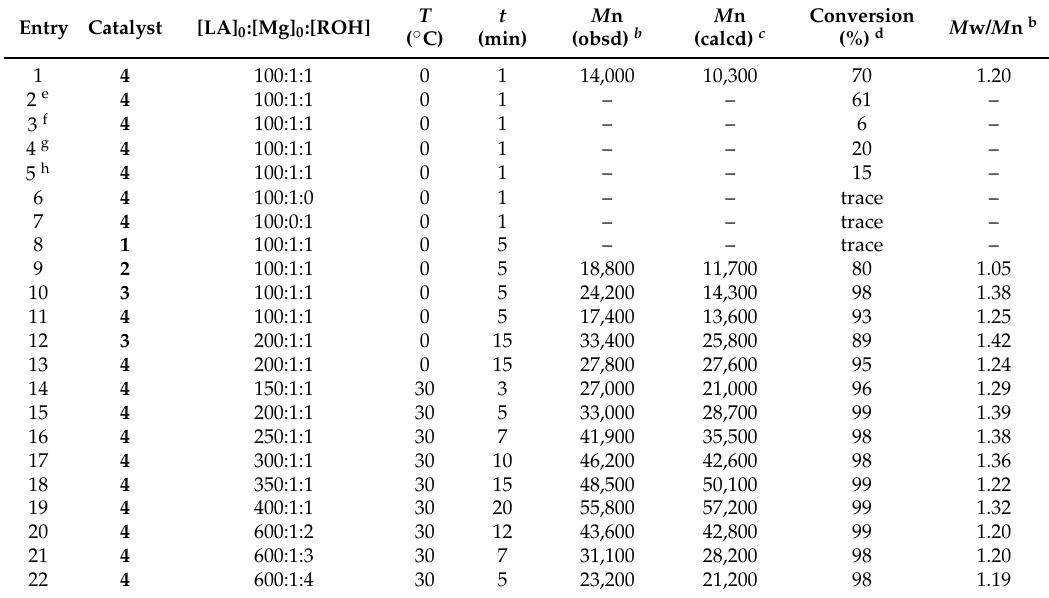
Table 3. Polymerization of L-LA using compounds 1 – 4 as catalysts in toluene if not otherwise stated. a